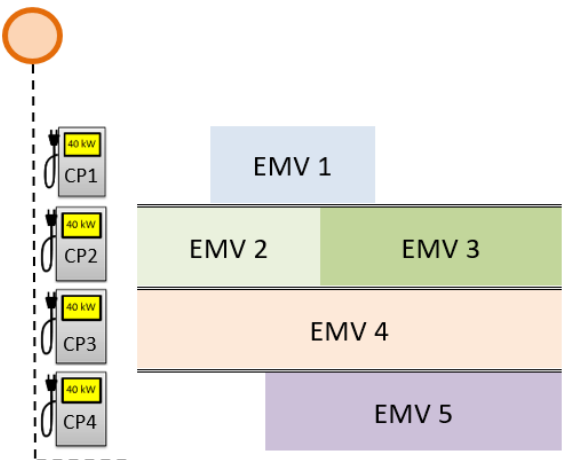
Figure 5. Excerpt of an exemplary 3D conflict matrix representing 5 charging points.